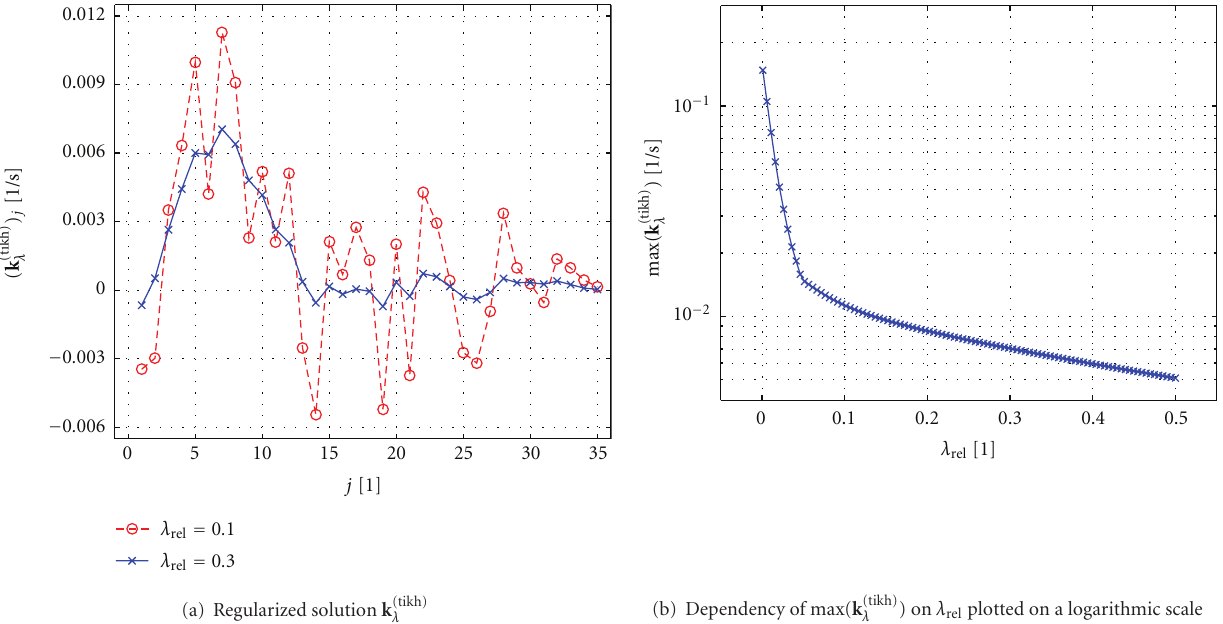
) on λ rel plotted on a logarithmic scale